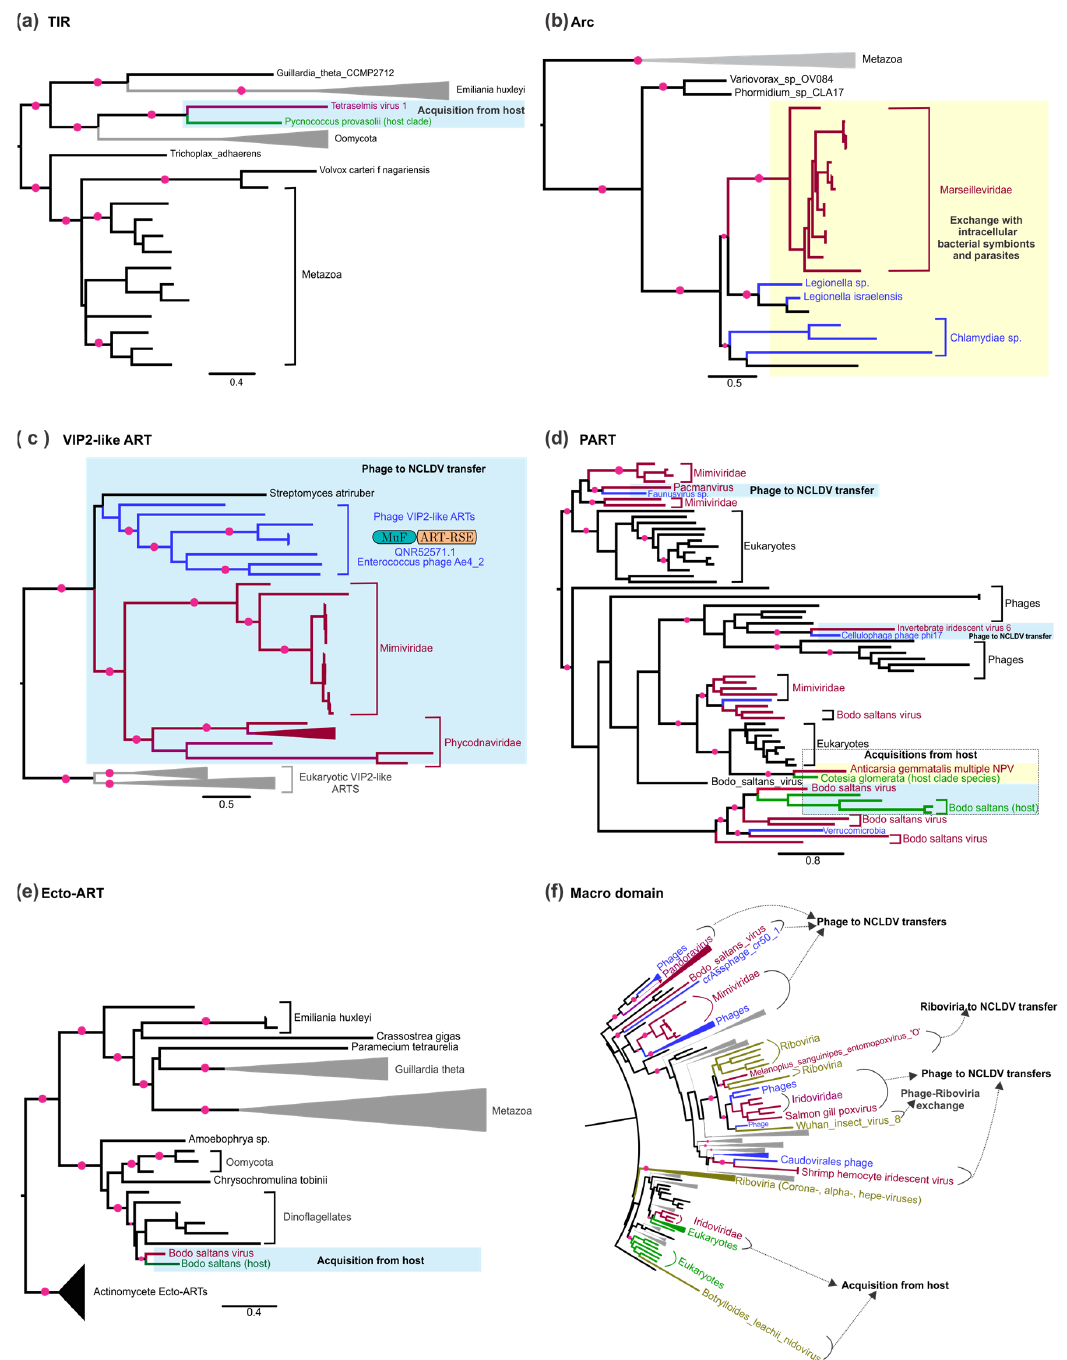
Figure 3. Phylogenetic trees of select viral NAD + –ADPr network components illustrating their origins as described in the text. ( a ) TIR, ( b ) Arc, ( c ) VIP2-like ART, ( d ) PART, ( e ) Ecto-ART, ( f ) Macro domain. Clades with a bootstrap support of > 75% are marked by colored circles. Several clades are collapsed in the trees for brevity. Relevant exchanges of genes are indicated. The raw data for the phylogenetic trees can be obtained from Supplementary S3.